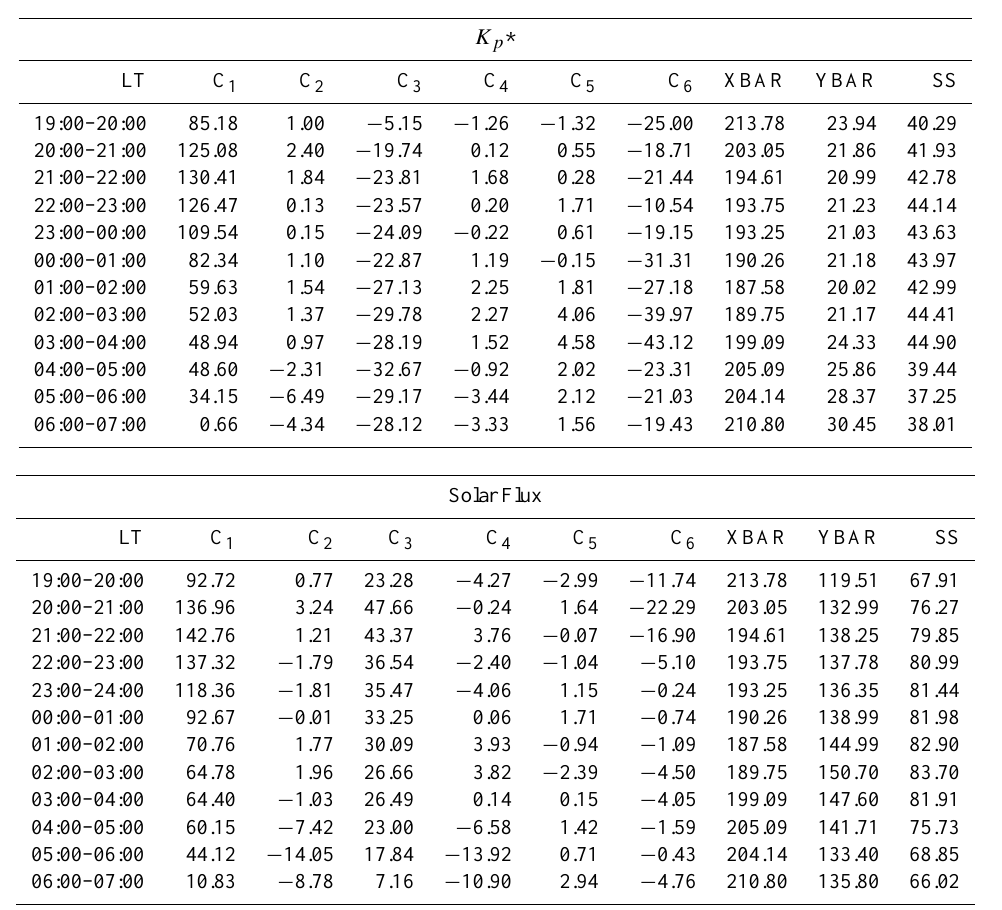
Table 1. Model coefficients for equation